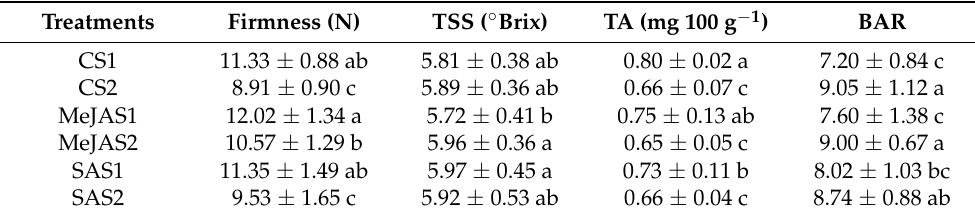
Table 1. Firmness, TSS, TA, and BAR of ‘Kumato’ tomato cultivar in the control and treatment (0.25 mM MeJA and 0.5 mM SA) groups at two maturity stages. Treatments Firmness